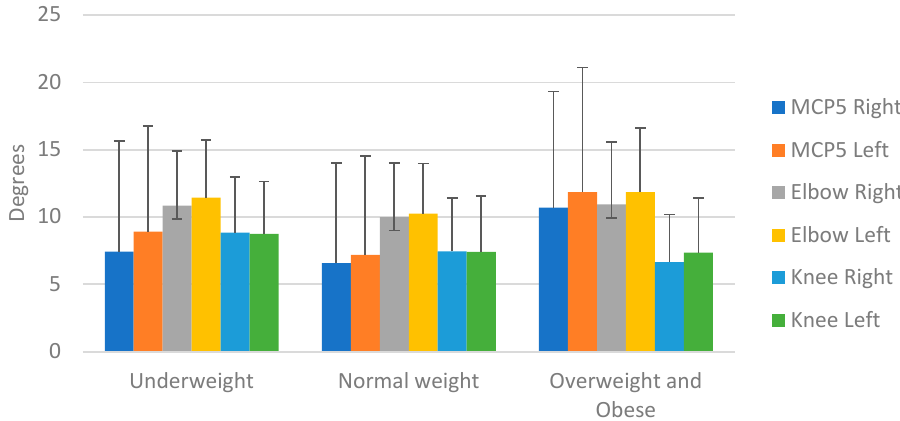
Figure 6. Range of motion per joint for the BMI classi fi cation groups.